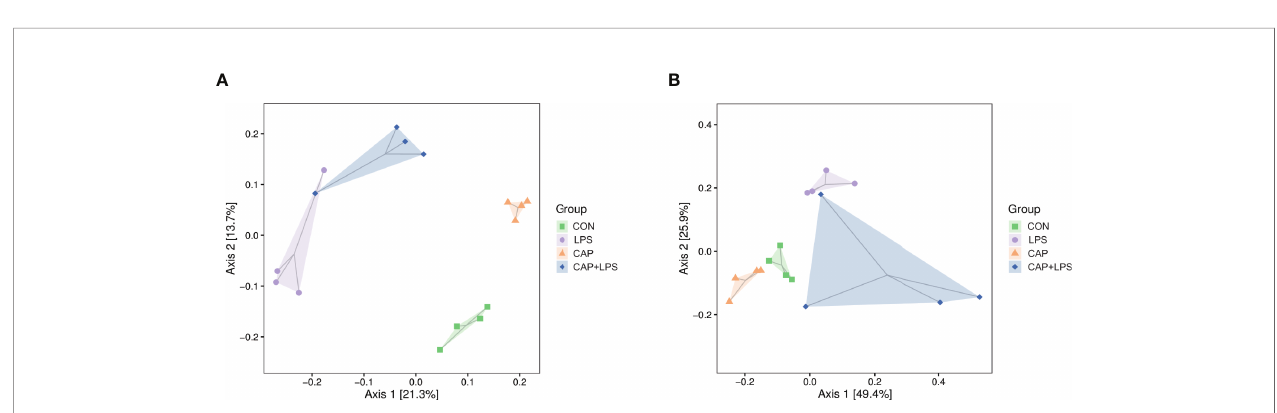
FIGURE 5 | (A) Unweighted UniFrac distance-based principal coordinate analysis (PCoA) (n = 4); (B) Weighted PCoA (n =